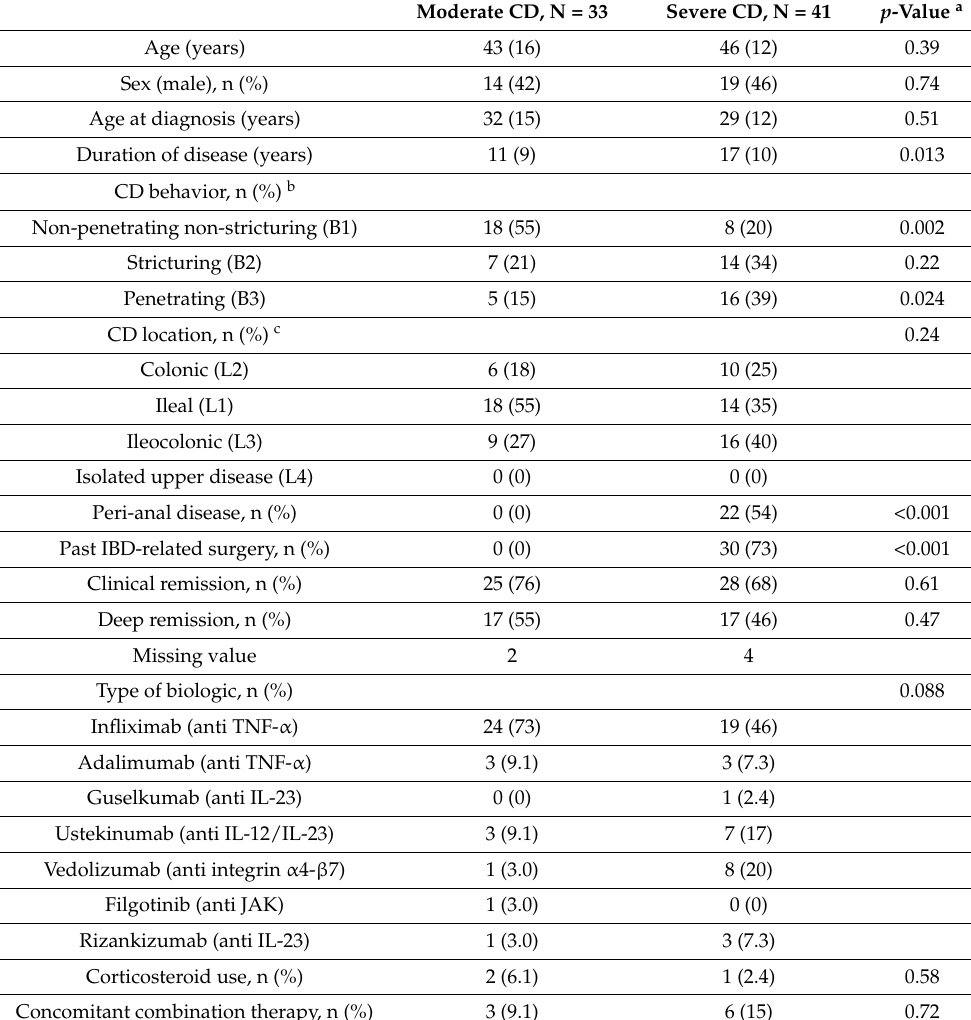
Table 1. Characteristics of the study population with and without Crohn’s disease.